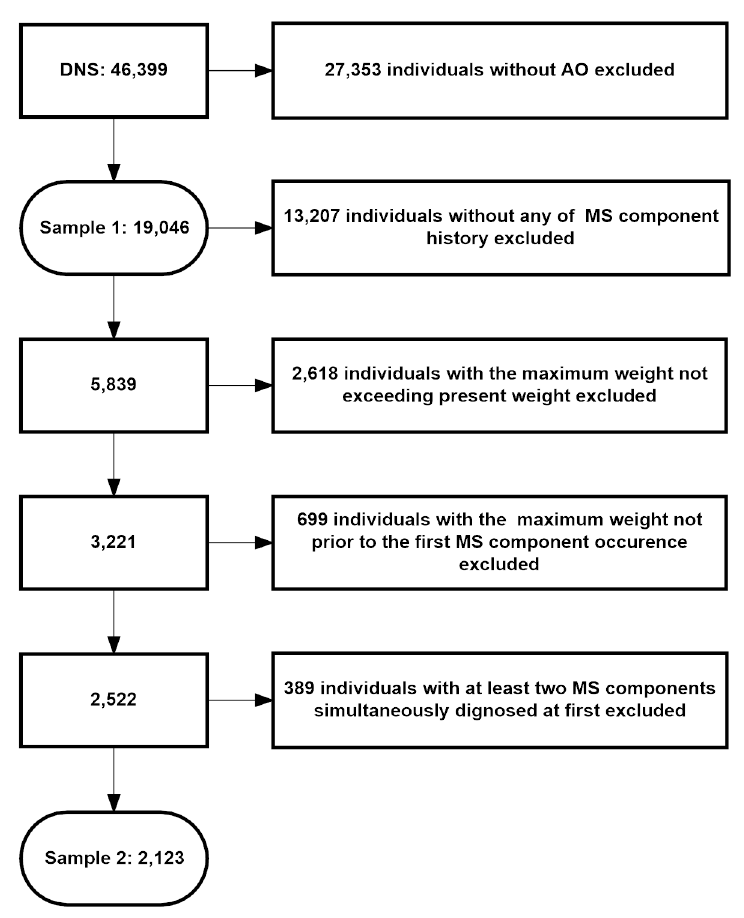
Figure 1. Flow chart of study participants. Abbreviations: MS: metabolic syndrome; AO: abdominal obesity. doi: